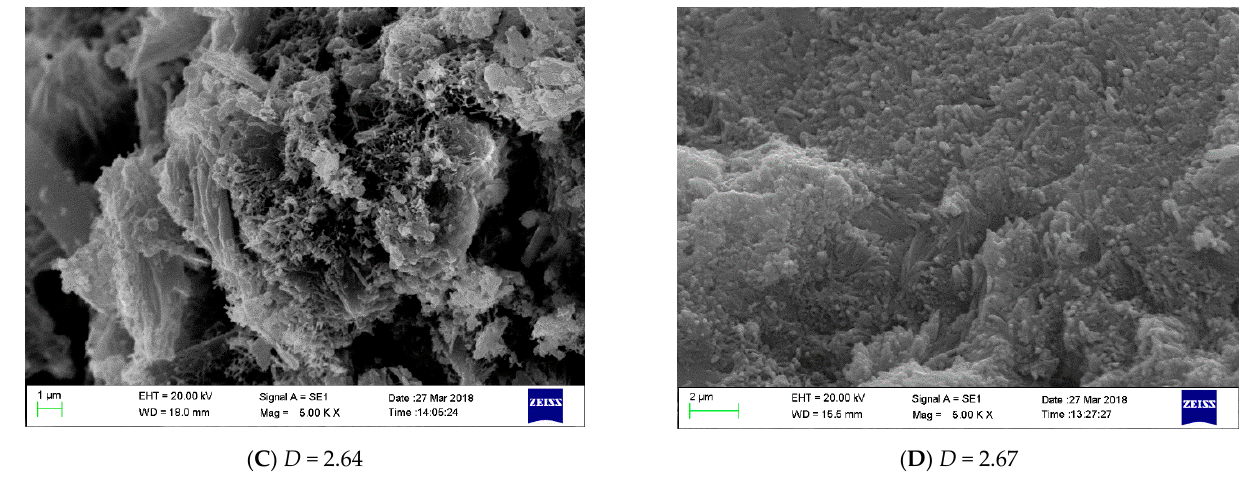
Figure 8. Microscopic morphology analysis.